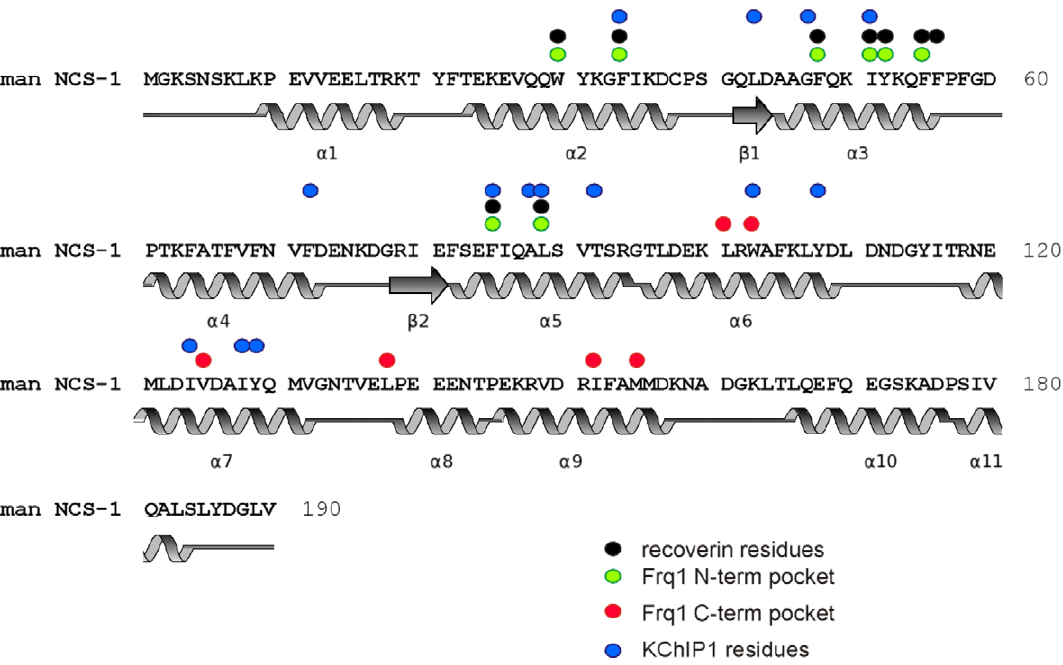
Figure 1. Conserved hydrophobic residues involved in protein target interactions in NCS proteins. The secondary structure elements indicated are obtained from the crystal structure of human NCS-1 (1G8I). The region between 134–138 is either unstructured or form a short helix; the latter is indicated in this figure. The residues identified to make contact with target peptides in the recoverin/rhodopsin kinase [33], Frq1/Pik1 [31] and KChIP1/Kv4 [35] complexes are indicated above the corresponding amino acids in NCS-1 which are all conserved hydrophobic residues. For the Frq1/Pik1 complex residues are indicated that interact with the two alpha helices of Pik1 n the N- and C-terminal parts of the hydrophobic groove.